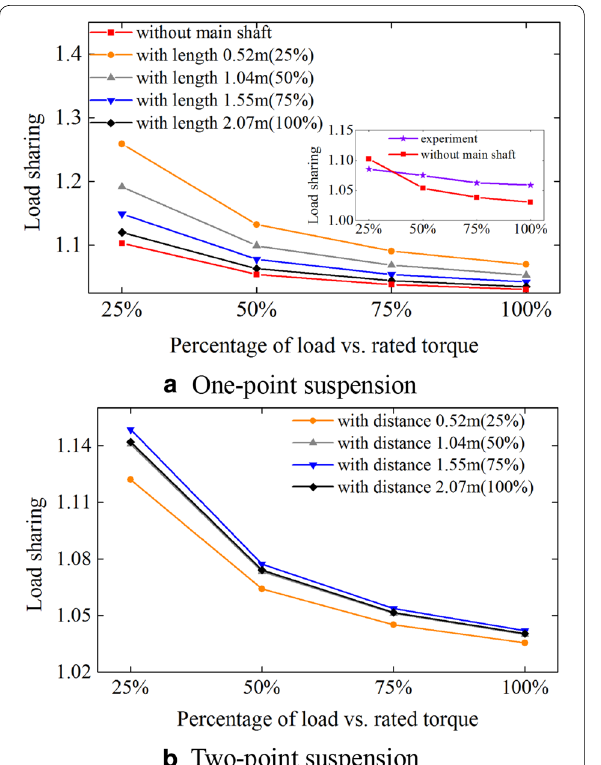
Figure 15 The load sharing in two suspension configurations